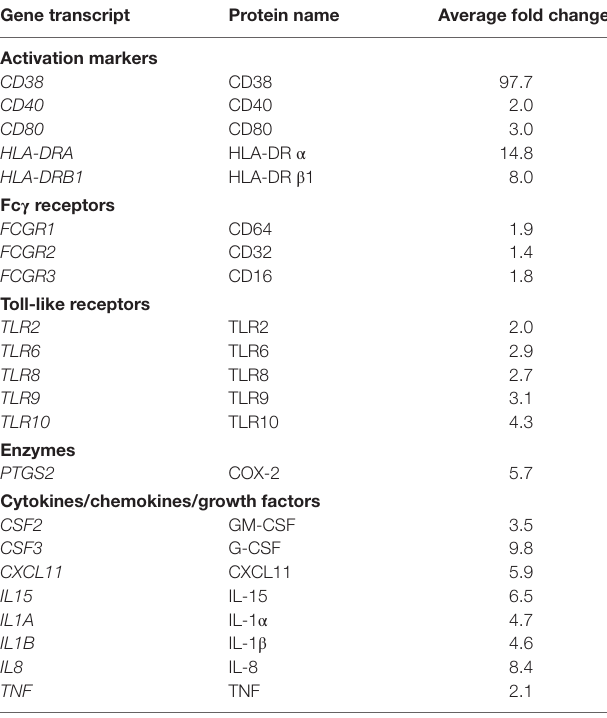
TaBle 1 | Transcription profile of M Φ (IFN γ )s. gene